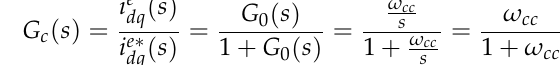
Figure 14. Block diagram of acquiring estimated current.